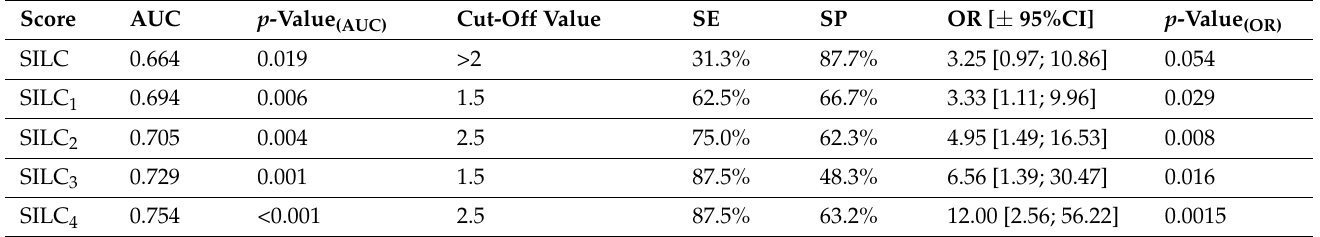
Table 5. Receiver operation characteristic analysis and logistic regression analysis for SILC and its